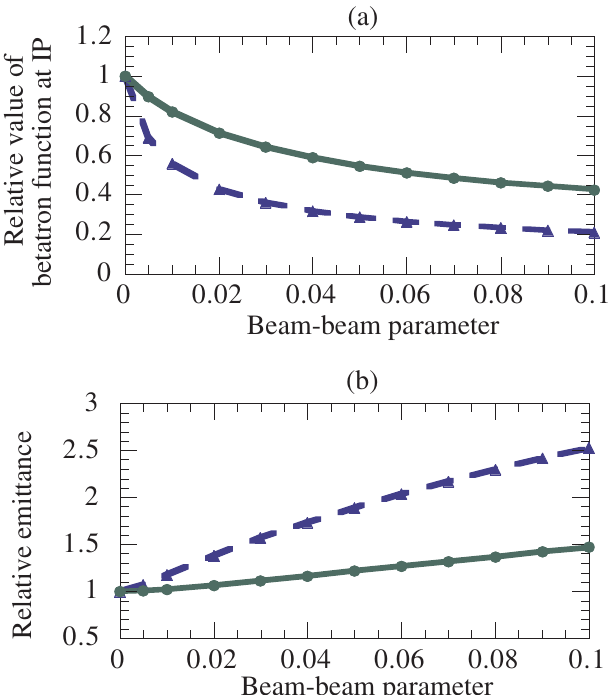
FIG. 1. (Color) Relative value of the betatron function at the IP (a) and relative value of the emittance (b) as a function of the beam-beam parameter. A value of 1.0 corresponds to a non- perturbed value. The green solid line was calculated with a fractional tune of 0.540, and the blue dashed line with a tune of 0.509.